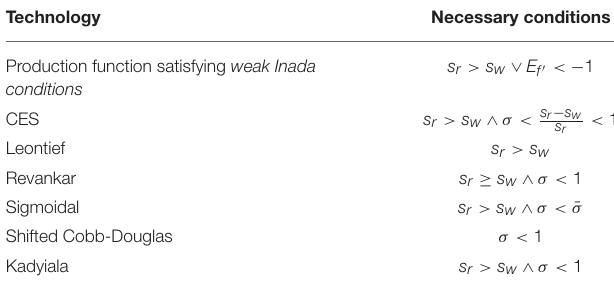
TABLE 2 | necessary conditions for complex dynamics.